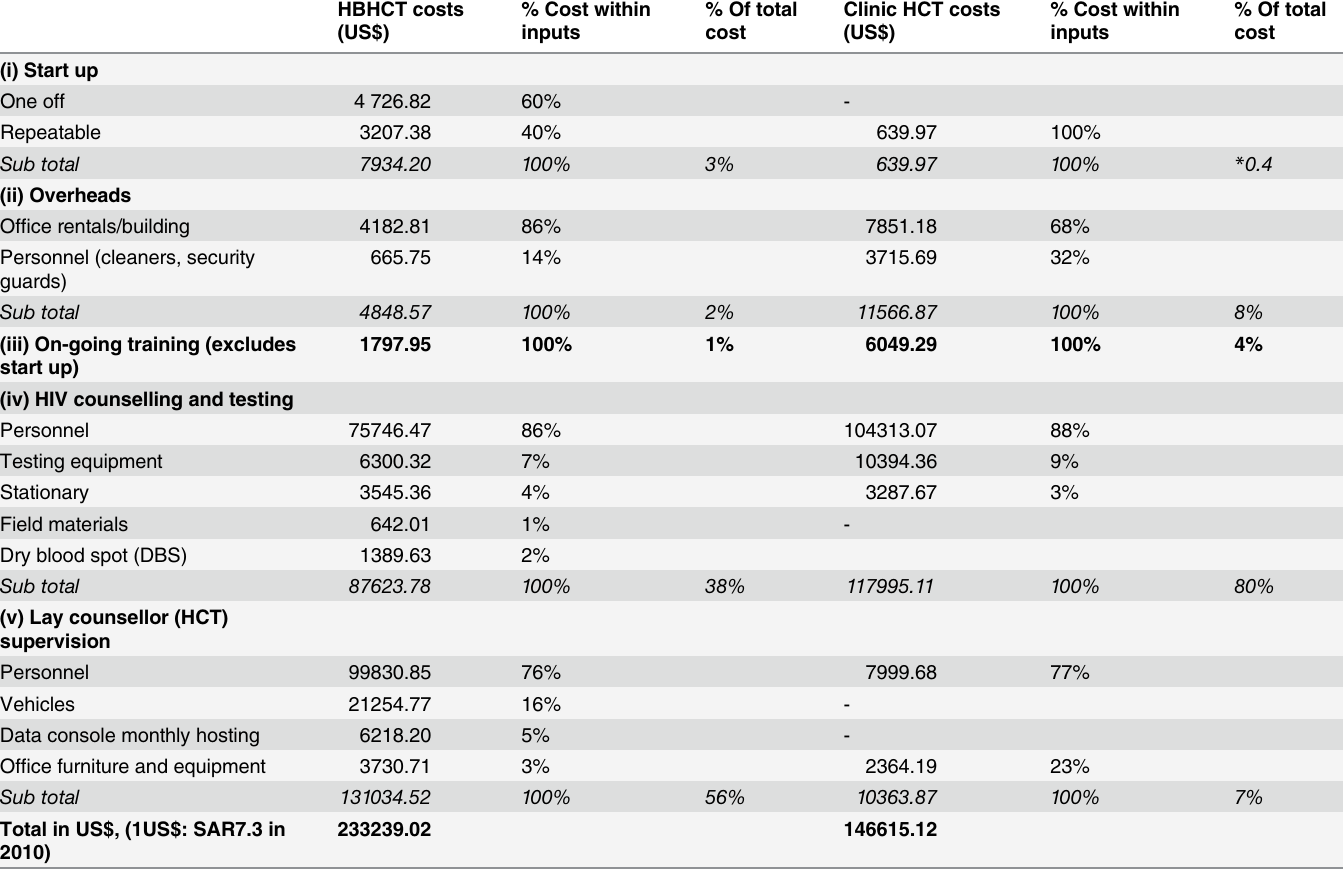
Table 3. Economic costs of inputs.